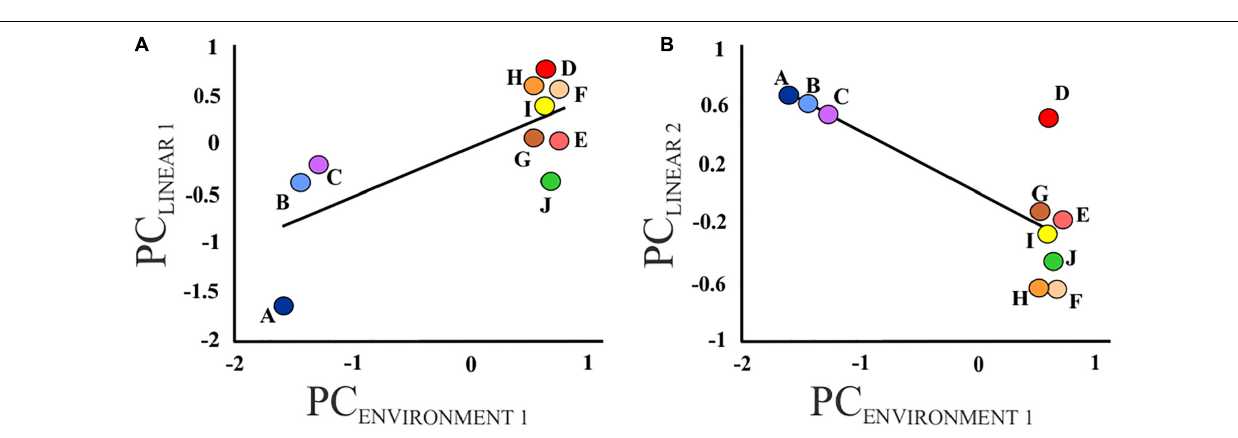
FIGURE 4 | Graphs illustrating the relationship between (A) body depth (PC LINEAR 1 ) and (B) gape size (PC LINEAR 2 ) and the environmental variables (PC ENVIRONMENT 1 ) for each sampled locality (A –